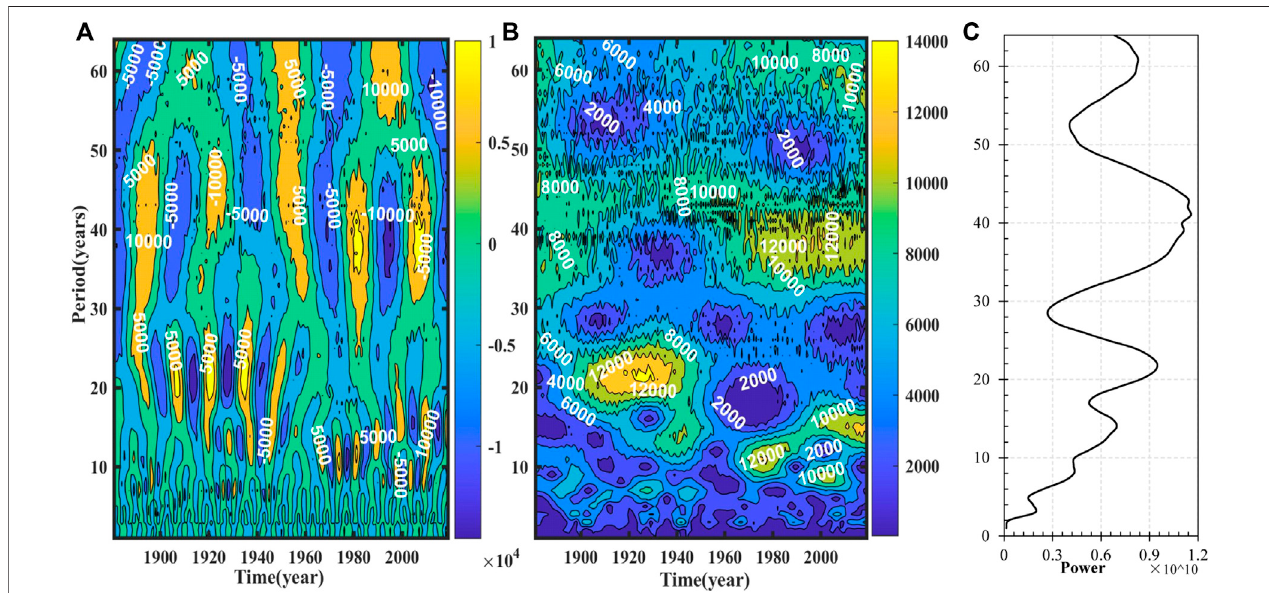
FIGURE 5 | Contour plots of the real part (A) , the modulus (B) , and the global power spectrum (C) of Morlet wavelet transform coef fi cients.